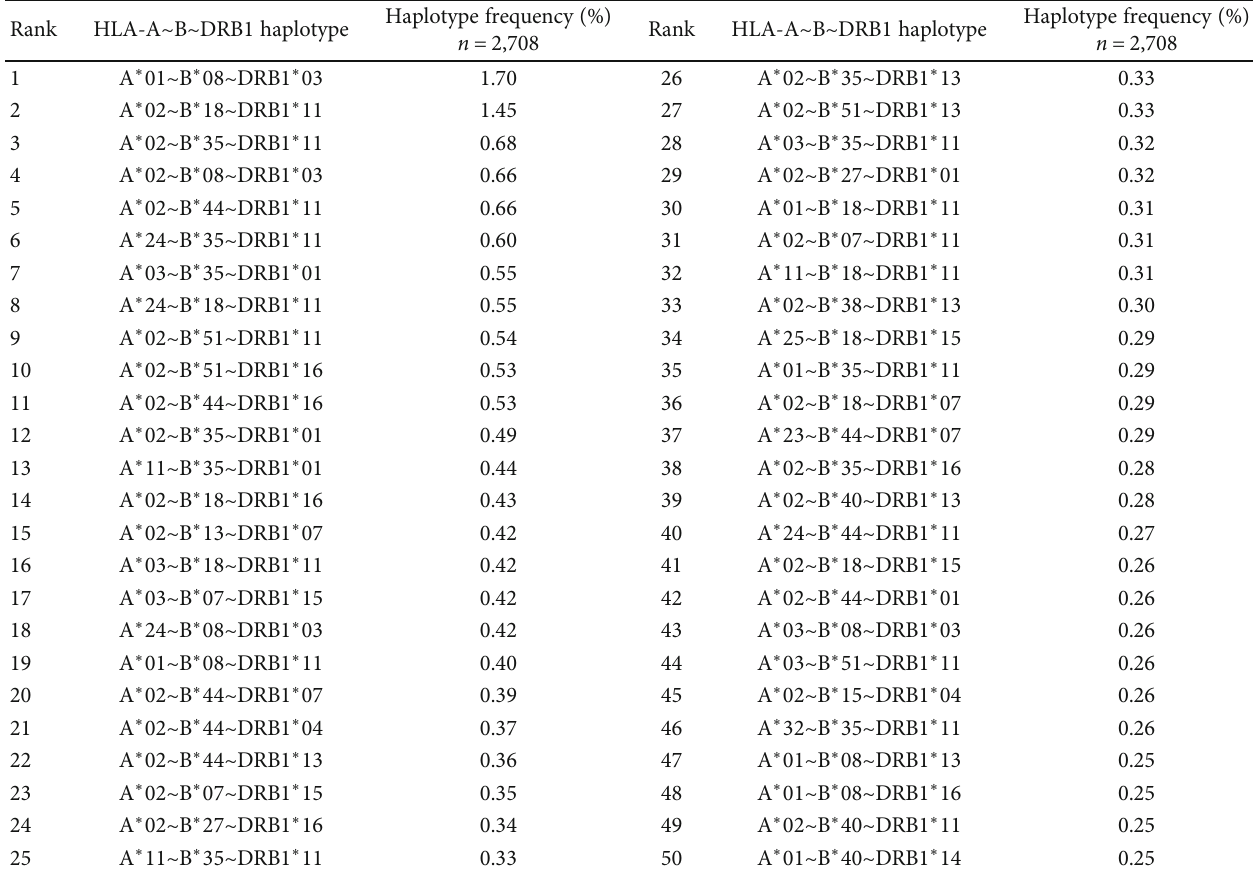
Table 3: The most frequent 50 HLA-A ~ B ~ DRB1 haplotypes from the 2,708 analyzed individuals presented in descending order of their